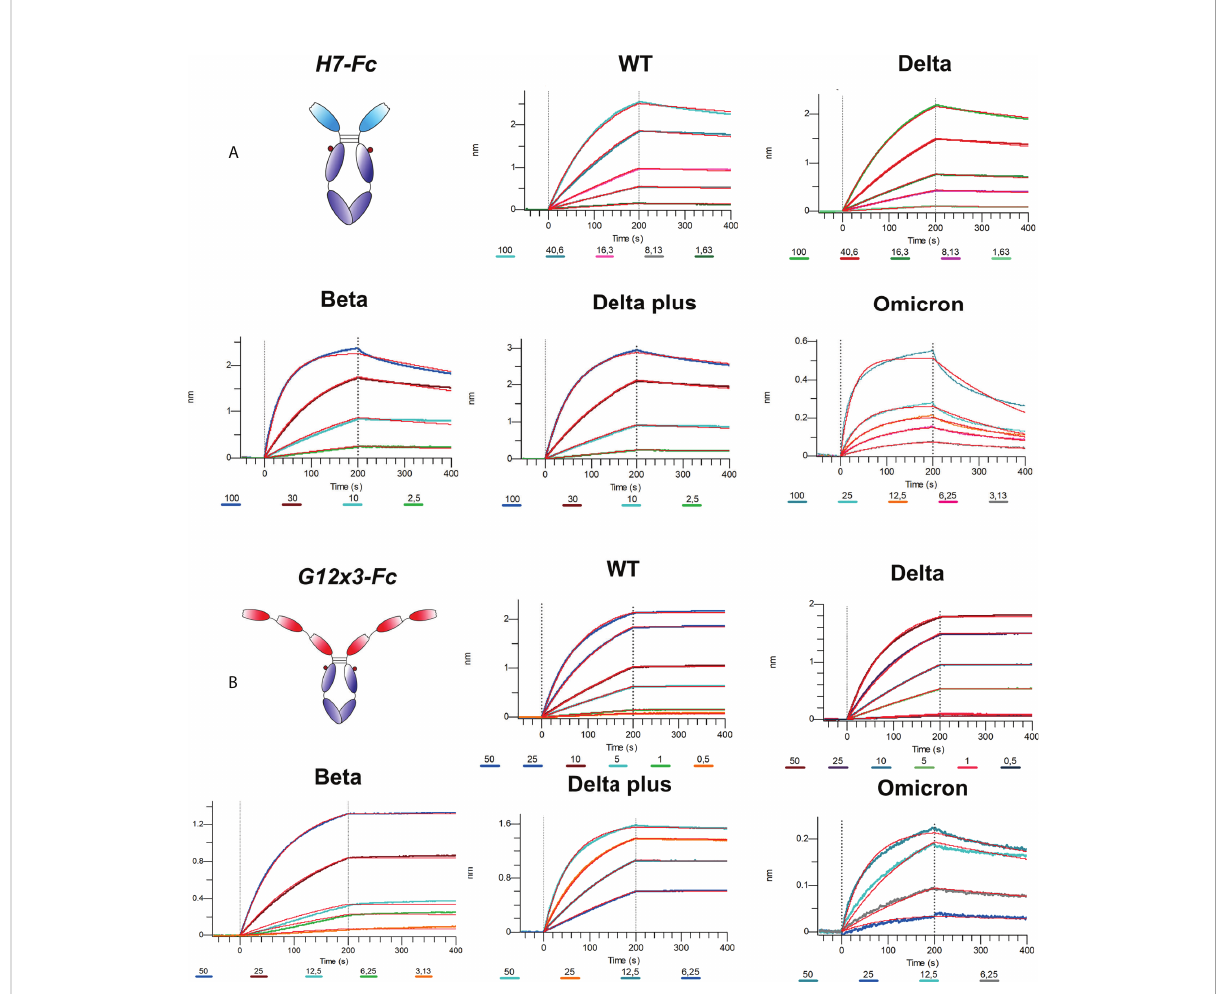
FIGURE 6 Multipoint BLI of H7-Fc (A) and G12x3-Fc (B) binders to SARS-CoV-2 VoC